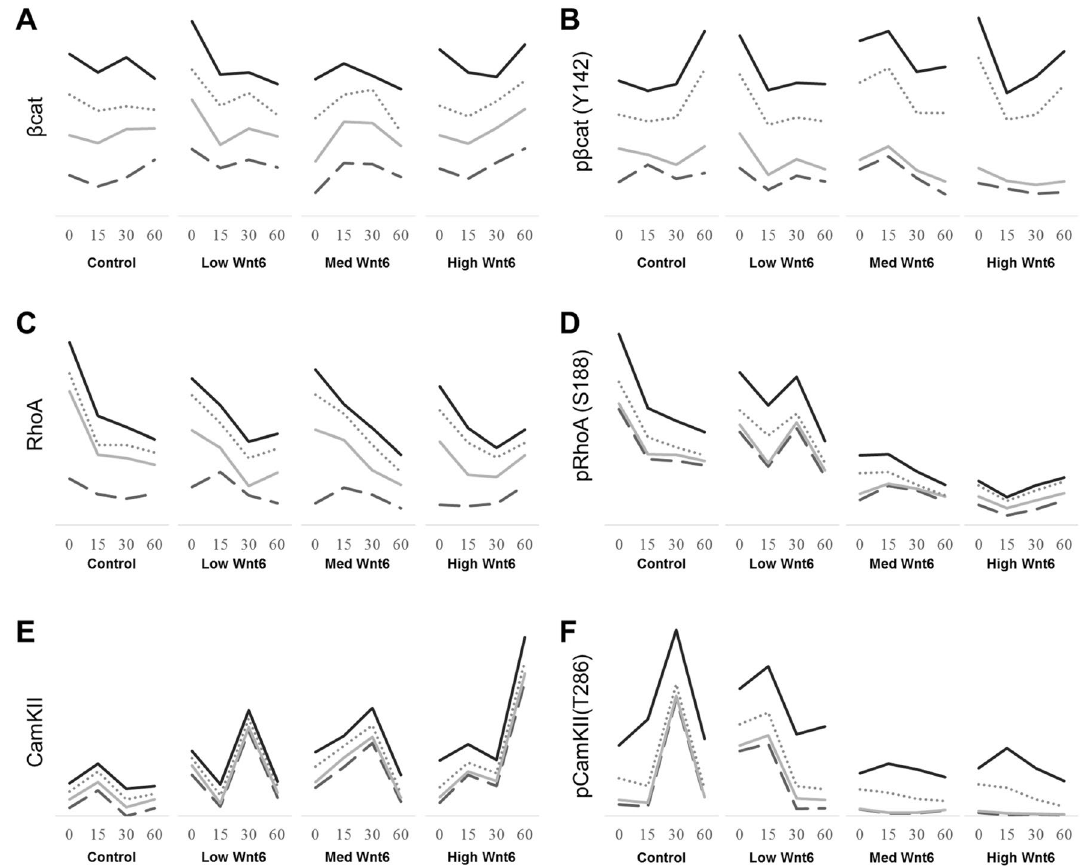
Figure 4. Quantitation of proteins involved in the Wnt pathway upon exposure to Wnt6. Stacked trends of individual donors measuring ( A ) β-catenin, ( B ) phosphorylated β-catenin (Y142), ( C ) RhoA, ( D ) phosphorylated RhoA (S188), ( E ) CamKII, and ( F ) phosphorylated CamKII (T286) at 0, 15, 30, and 60 min after treatment with control, low-, medium-, and high-Wnt6 conditional medium (CM). Treatment with low-Wnt6 CM resulted in immediate increases in β-catenin concentration. Treatment with medium-Wnt6 CM resulted in increases 15 min after exposure. Treatment with high-Wnt6 CM increased β-catenin 60 min after exposure. Activation of β-catenin as determined by phosphorylated β-catenin (Y142) concentrations was observed immediately after treatment with low-, medium-, and high-Wnt6 CM. Control medium also activated β-catenin at 60 min from residual 3T3-expressed Wnt ligands. RhoA expression showed a general reduction, whereas phosphorylation of RhoA was lost immediately upon treatment with medium- or high-Wnt6 CM. An increase in CamKII expression was detected almost immediately after Wnt6 treatment, and maximum levels were detected 30–60 min after Wnt6 treatment. Phosphorylation of CamKII was lost immediately during medium- or high-Wnt6 CM treatment. Each line represents the quantities from individual donors. Donor 1, solid black, 9000 cells/cm 2 ; Donor 2, dotted gray, 3250 cells/cm 2 ; Donor 3, solid gray, 8000 cells/cm 2 ; Donor 4, gray dash, 13,500 cells/cm 2 . Normalized to GAPDH. Phosphorylated proteins were normalized to the levels of their unphosphorylated